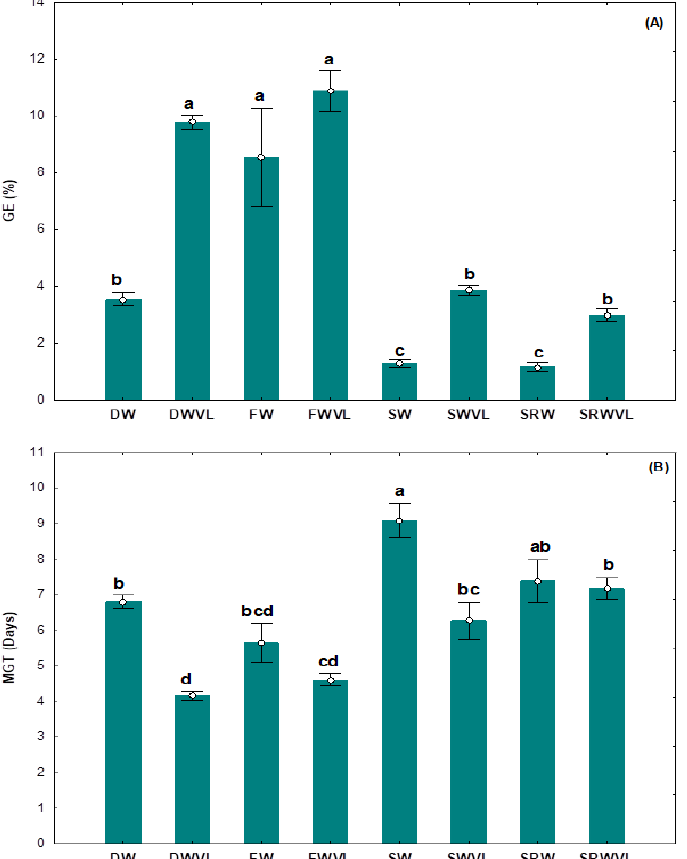
Figure 5. ( A ) Germination energy (GE), and ( B ) mean germination time (MGT) of Salicornia bigelovii germinated seeds under different water treatments. Same letters above bars denote no-significant differences; vertical lines at the top of bars are the standard deviation ( n = 4).